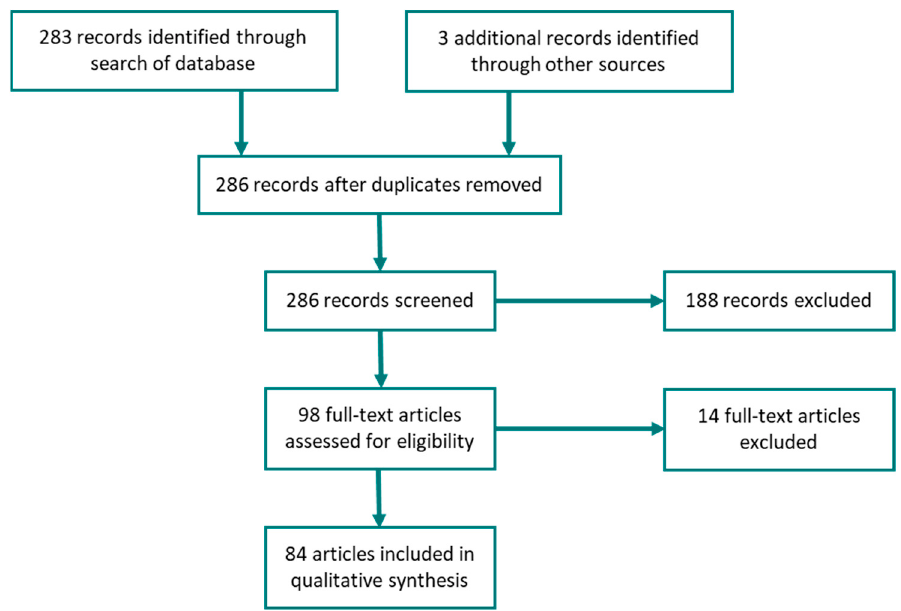
Figure 1. Systematic screening process for eligibility of articles included in this review.